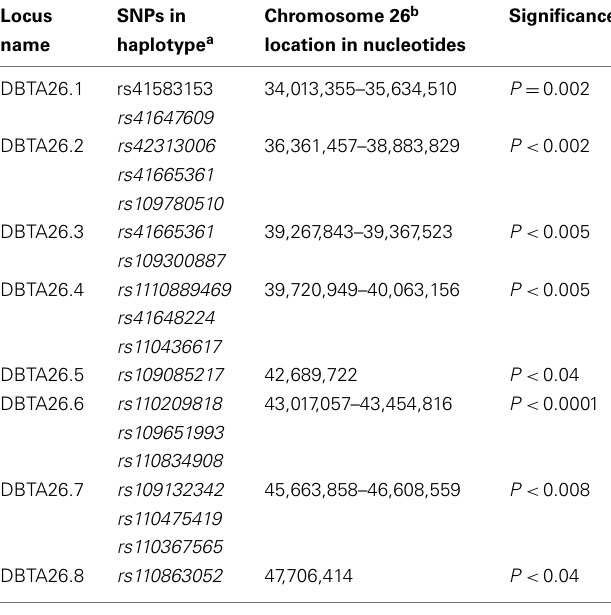
Table 4 | Haplotypes associated with bovine viral diarrhea persistently infected calves on BTA26 using the allelic